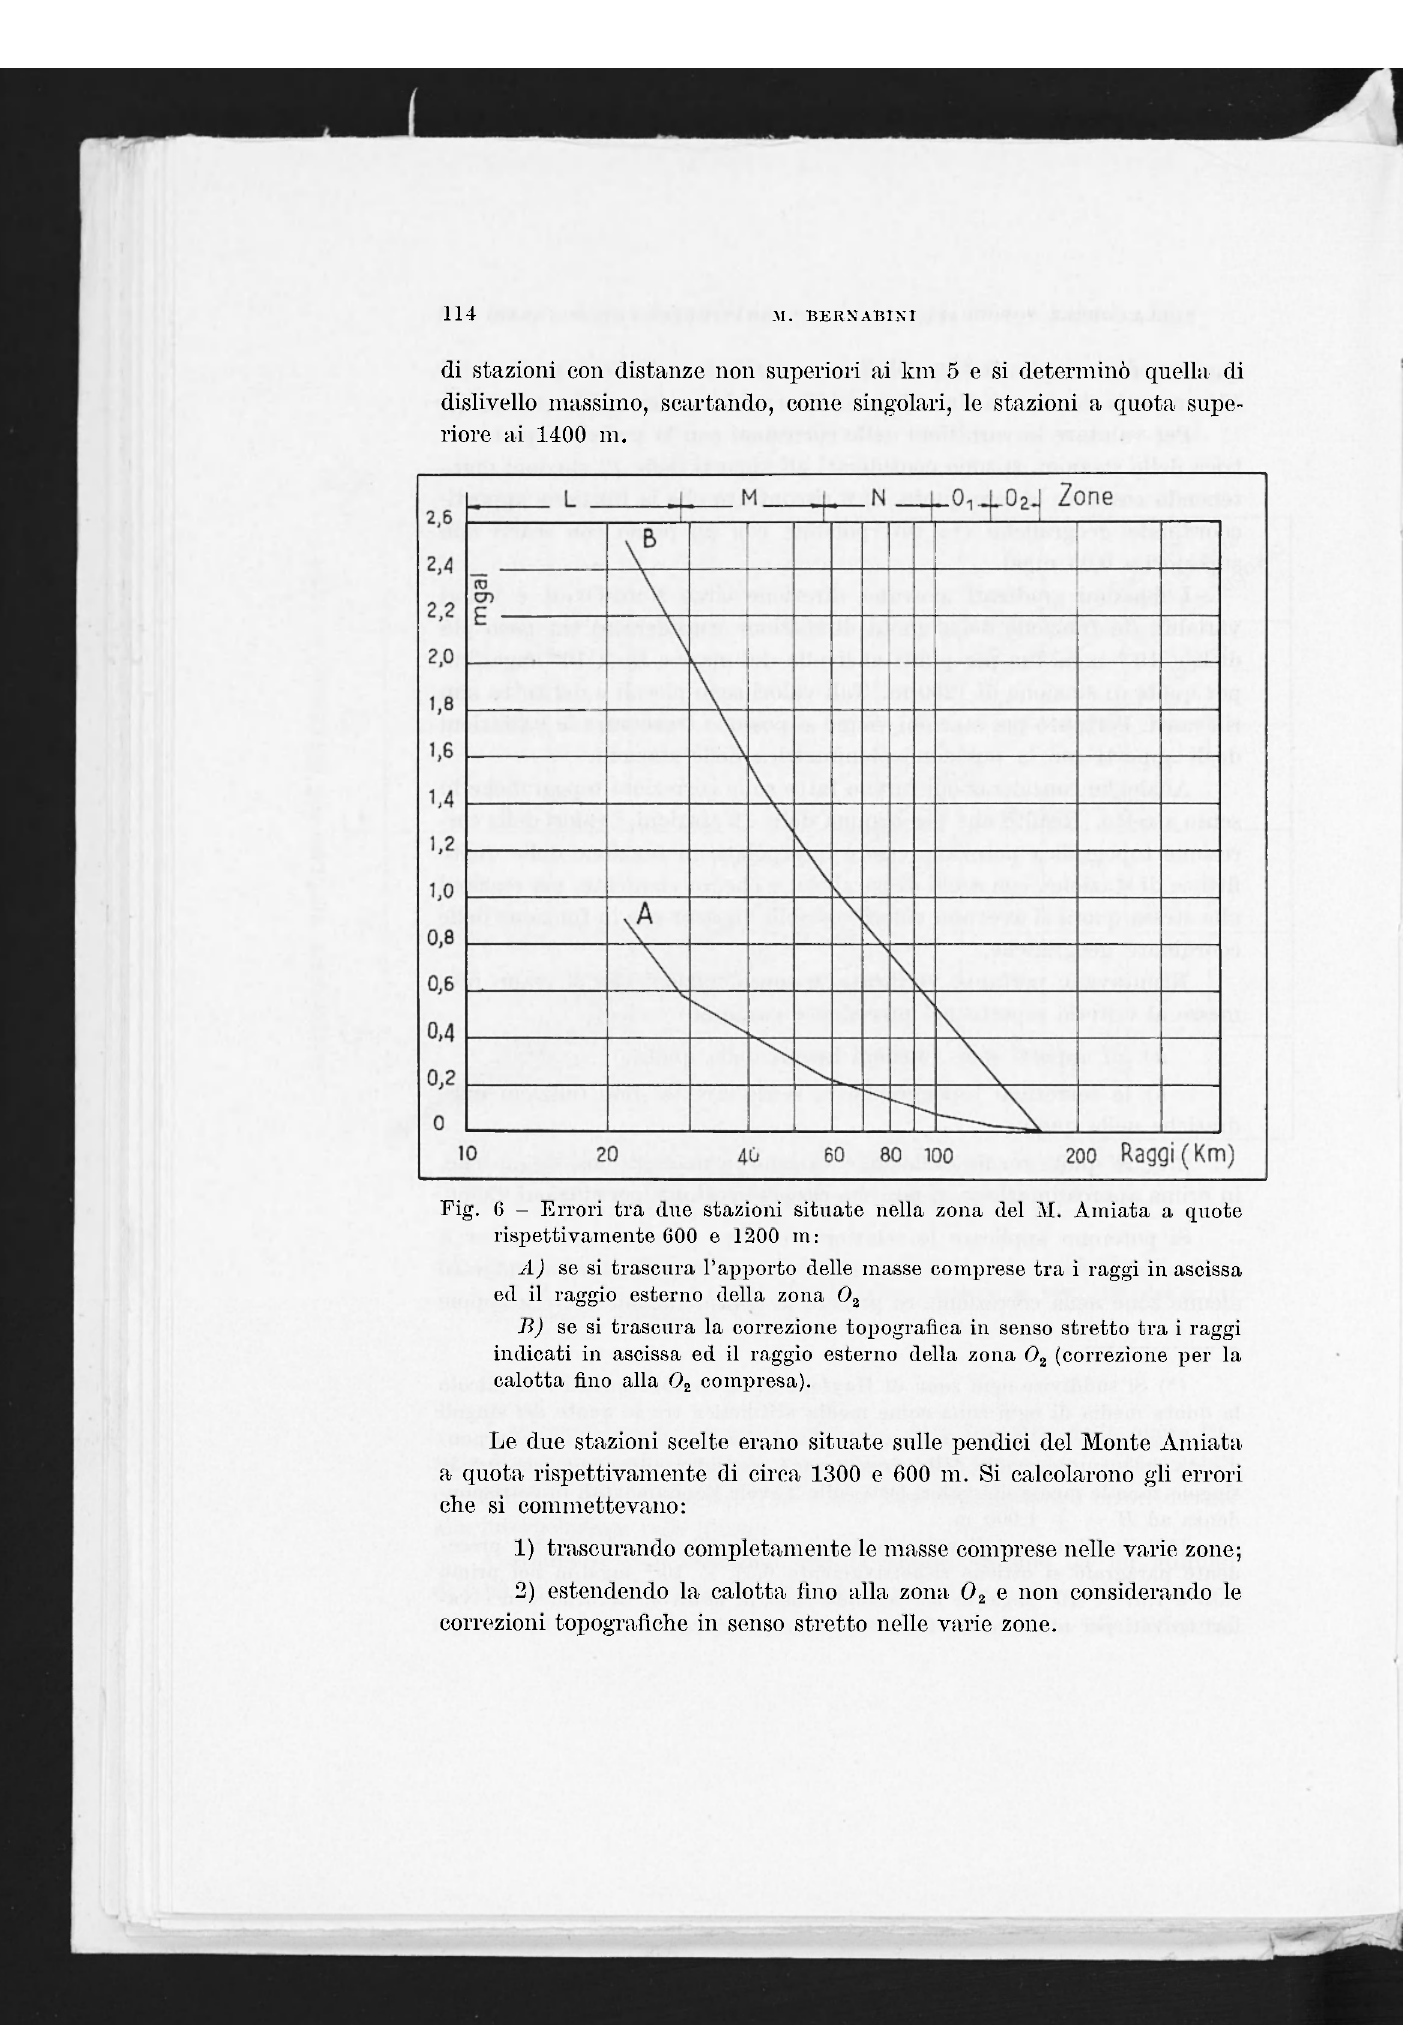
Fig. 6 - Errori tra due stazioni situate nella zona del M. Amiata a